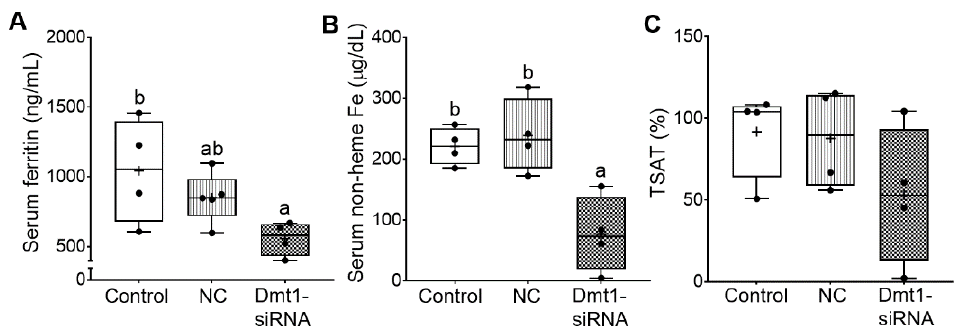
Figure 8. FA-GDLVs/DMT1 siRNA treatment decreased whole body and serum iron content. Shown are serum ferritin levels ( A ), serum non-heme Fe content ( B ), and blood TSAT ( C ). Data were analyzed by one-way ANOVA ( A – C ), followed by Tukey’s multiple comparisons test ( A , B ). Data are presented as box plots for n = 4–5 mice per group. Groups labeled with different letters differ significantly. p = 0.0433 ( A ), p = 0.0036 ( B ). NC, negative control; +, mean value.